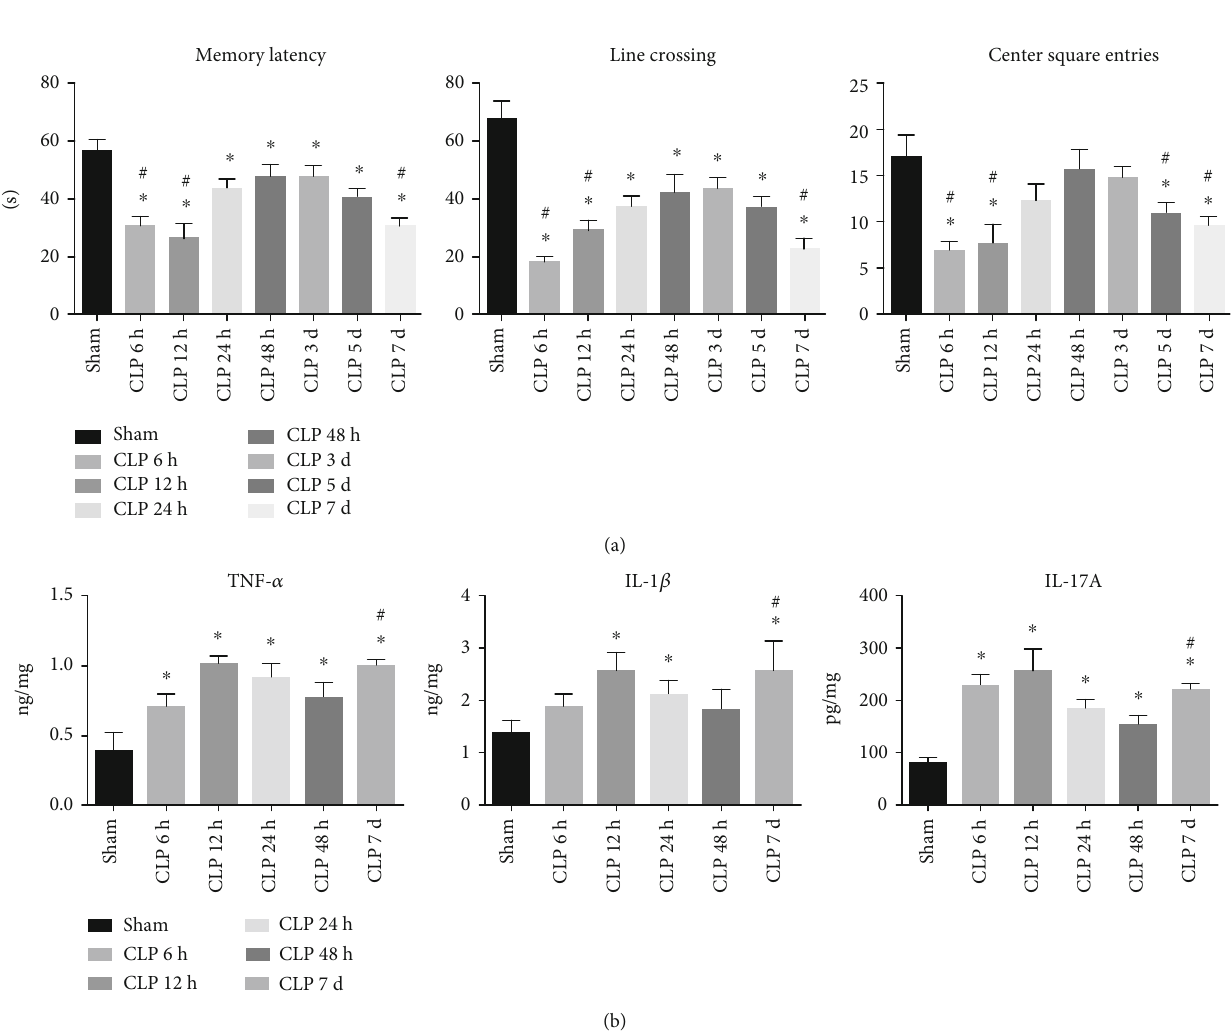
Figure 1: (a) Behavior performance was evaluated by the inhibitory avoidance test and the open fi eld test at various time points following sham or CLP procedures. Each experiment was performed in triplicate and repeated at least twice ( n = 5 ‐ 7 per group). (b) Cytokines of IL-17A, IL-1 β , and TNF- α in brain homogenate were determined by ELISA. ∗ P < 0 : 05 vs. sham control, # P < 0 : 05 CLP day 7 vs. CLP 48 h, n = 5 ‐ 6 per